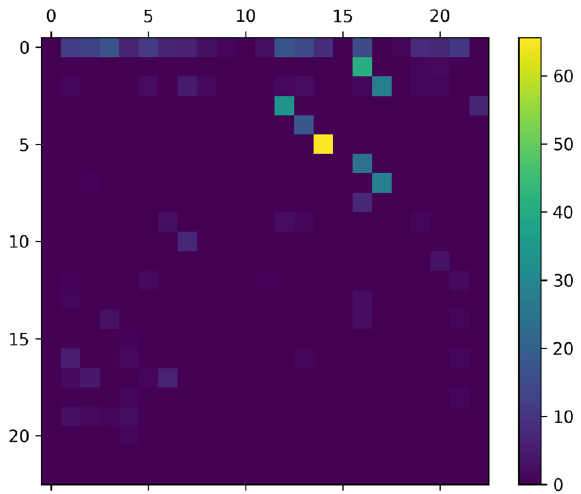
Figure 3. The overall demand matrix (as defined in Eq. (5) for the Aisin Logistics Problem of “Aisin Corporation vehicle routing problem”. Note that of the 23 2 = 529 entries for the matrix, only 115 are nonzero (figure generated by the authors using matplotlib 3.6.3 found at https:// pypi. org/ proje ct/ matpl otlib/).